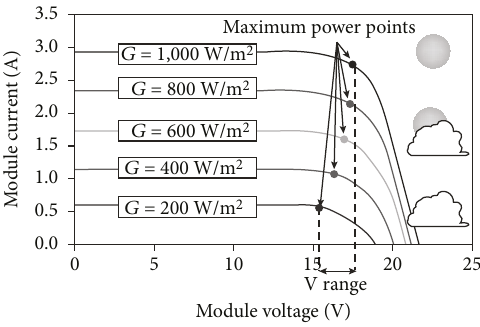
2: The e ff ect of temperature on PV cells